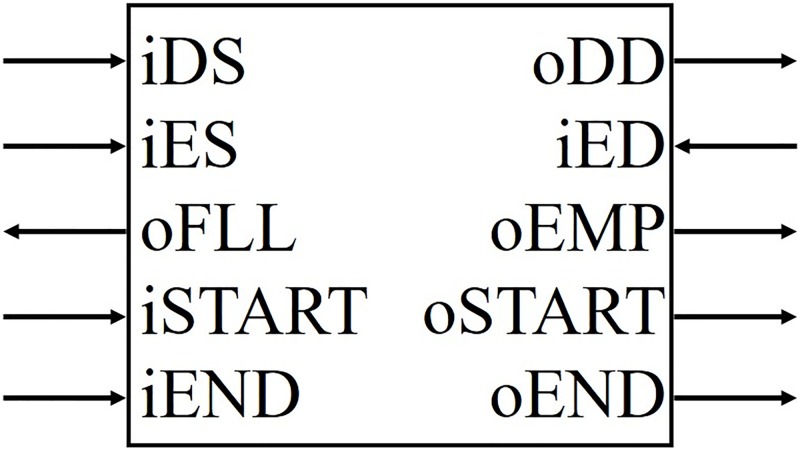
Common interface.